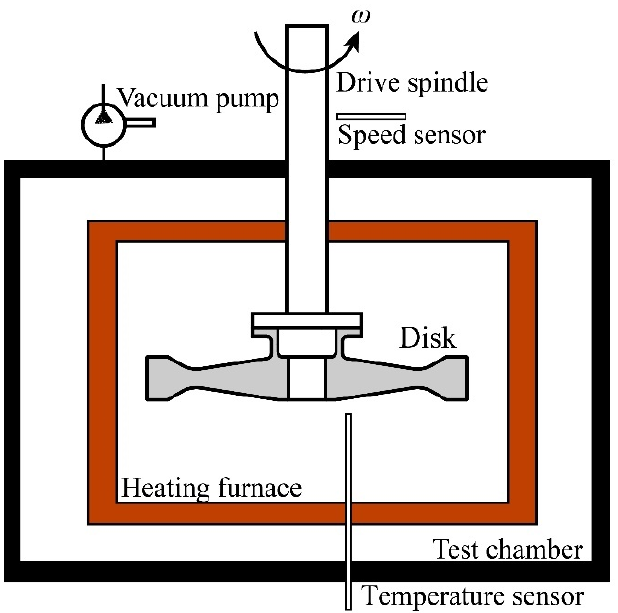
Figure 11. Schematic of the test device.